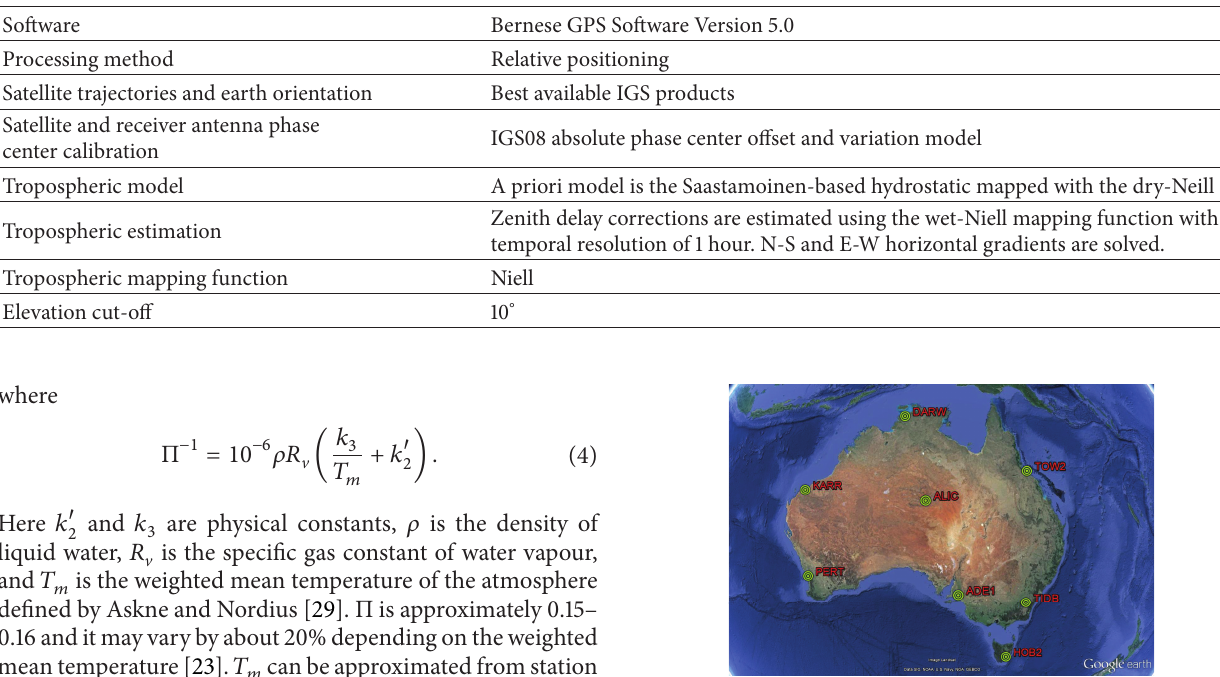
Table 1: GPS tropospheric ZPD computation strategy.